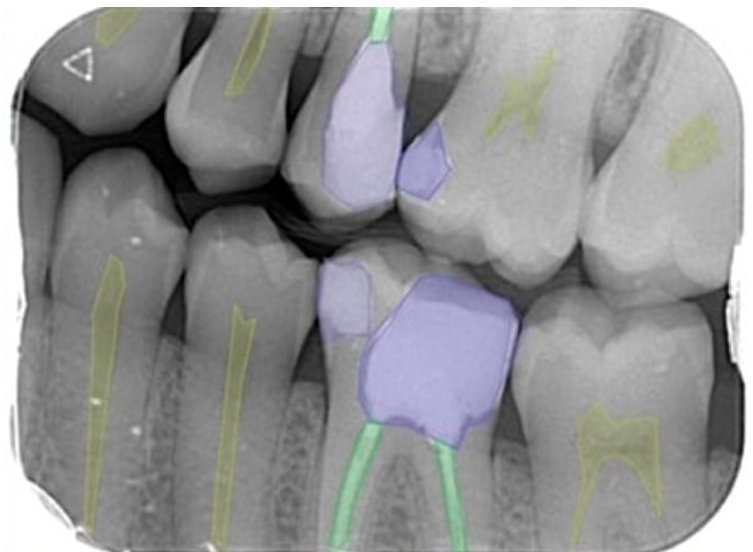
Figure 1. Polygonal style on bite-wing radiography image; labeling for 5 different dental diagnoses as dental pulp, dental caries, dental restorative filling material, dental crown, and dental root canal filling material.